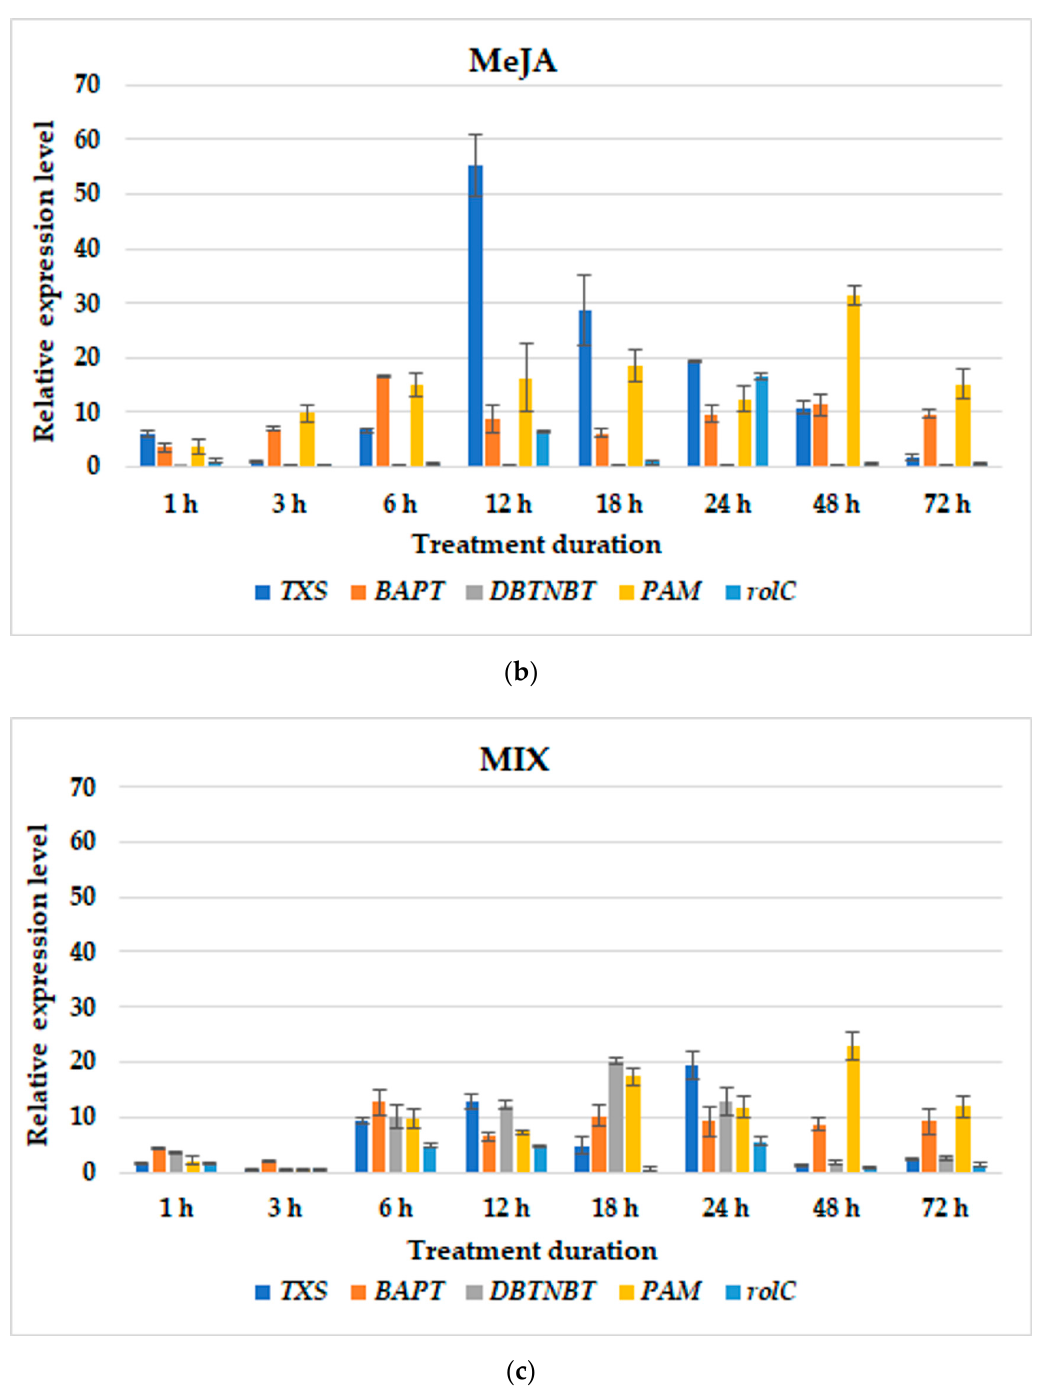
Figure 5. The effect of BABA24 treatment followed by ETOH ( a ), MeJA ( b ) or MIX ( c ). Elicitation on relative gene expression profiles in hairy root cultures. Data represent mean values ± SD from three independent experiments.